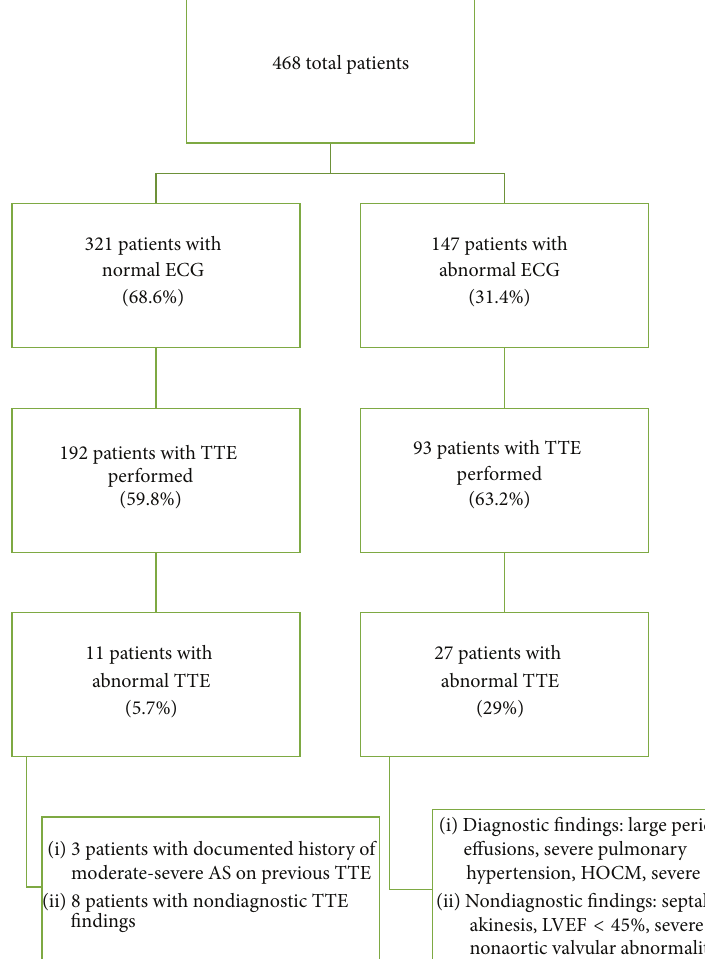
Figure 1: Patient segregation flowchart. ECG, electrocardiogram. TTE, transthoracic echocardiogram. HOCM, hypertrophic cardiomyopa- thy. AS, aortic